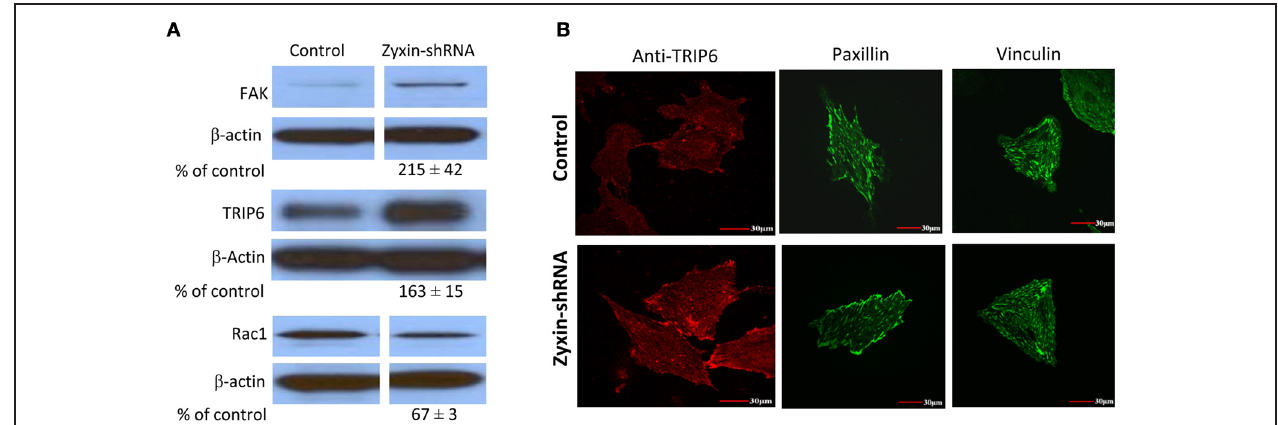
FIGURE 8 | Zyxin silencing increased FAK and TRIP6 expression, but decreased Rac1 expression in VSMC. (A) Western blots showed that FAK and TRIP6 expression were increased, but Rac1 was decreased in cells stably expressing zyxin-shRNA compared to cells expressing non-silencing control. Blots were quantified and normalized to β -actin and presented as percentage of the control. (B) Immunofluorescence